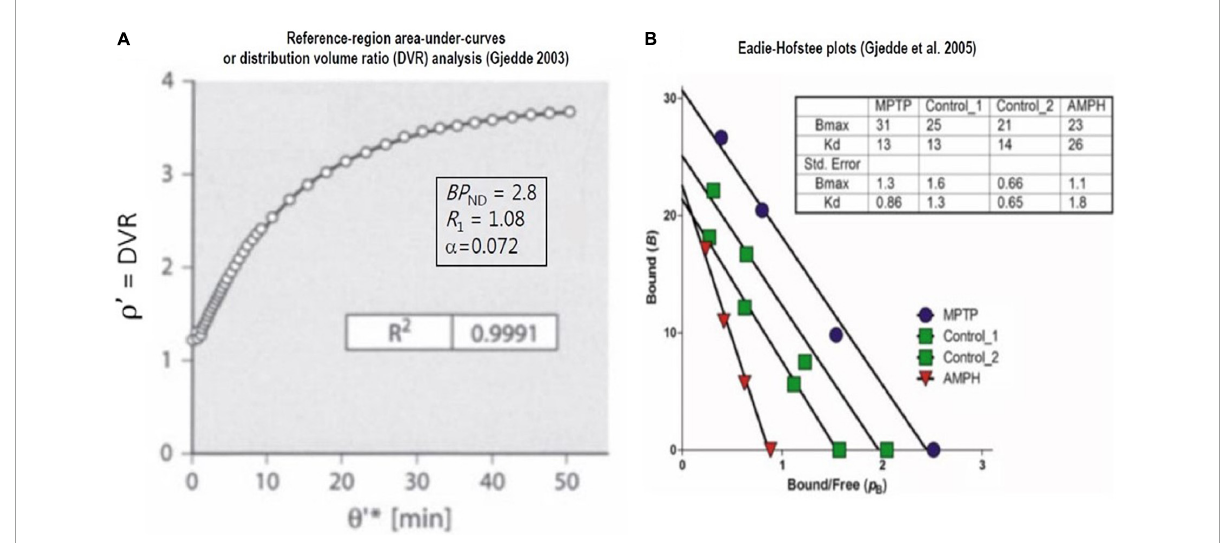
FIGURE8 Saturable binding relative to reference region: Reversible binding of [ 11 C]raclopride. Graphical plots of irreversibly binding radiotracer with reference region. (A) Shows plot of distribution volume ratio (DVR) of reversible radioligand vs. double integral of reference region in single subject (Gjedde, 2003). (B) Shows Eadie-Hofstee plots of bound ligand ( B ) vs. binding potential ( p B or BP ND ) of [ 11 C]raclopride in monkeys post-MPTP compared to controls, yielding estimates of receptor density ( B max ) and half-saturation mass ( K’ D ), reported by Holden et al. (2002) and adapted by Gjedde et al.